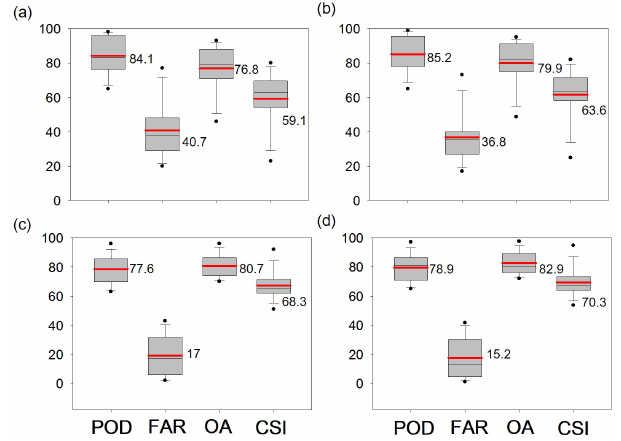
Figure 5. Quantitative assessment based on deterministic RF before and after postprocessing. (a) Validation metrics of RF using light- ning data before postprocessing. (b) Validation metrics of RF using lightning data after postprocessing. (c) Validation metrics of RF us- ing radar CAPPI data before postprocessing. (d) Validation metrics of RF using radar CAPPI data after postprocessing. The values next to boxes correspond to the average metric values as a percentage.